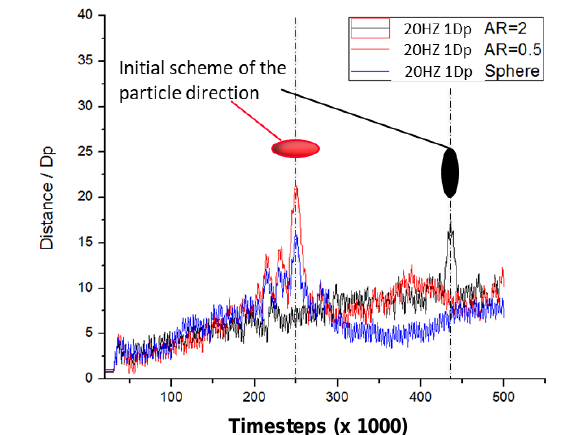
Fig. 8. Time evolution of the vertical position of the large intruder. Vibration frequency: 20 Hz; Vibration amplitude: 10 mm. The equivalent size of the large intruder: 20